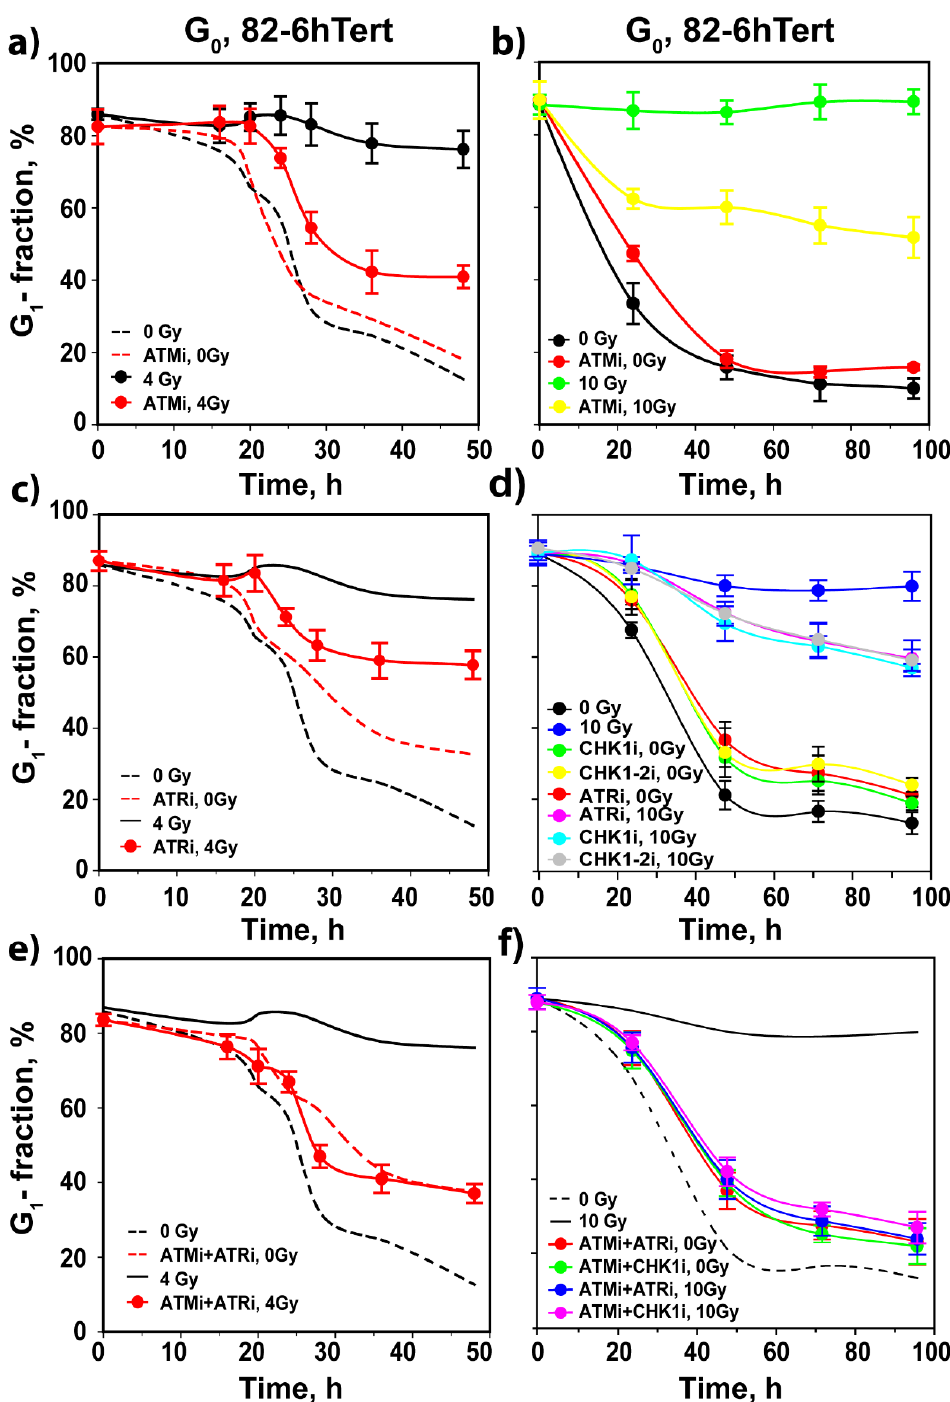
to avoid congestion. Plotted is the mean and SE from three independent experiments. See also Table S3 for more information.